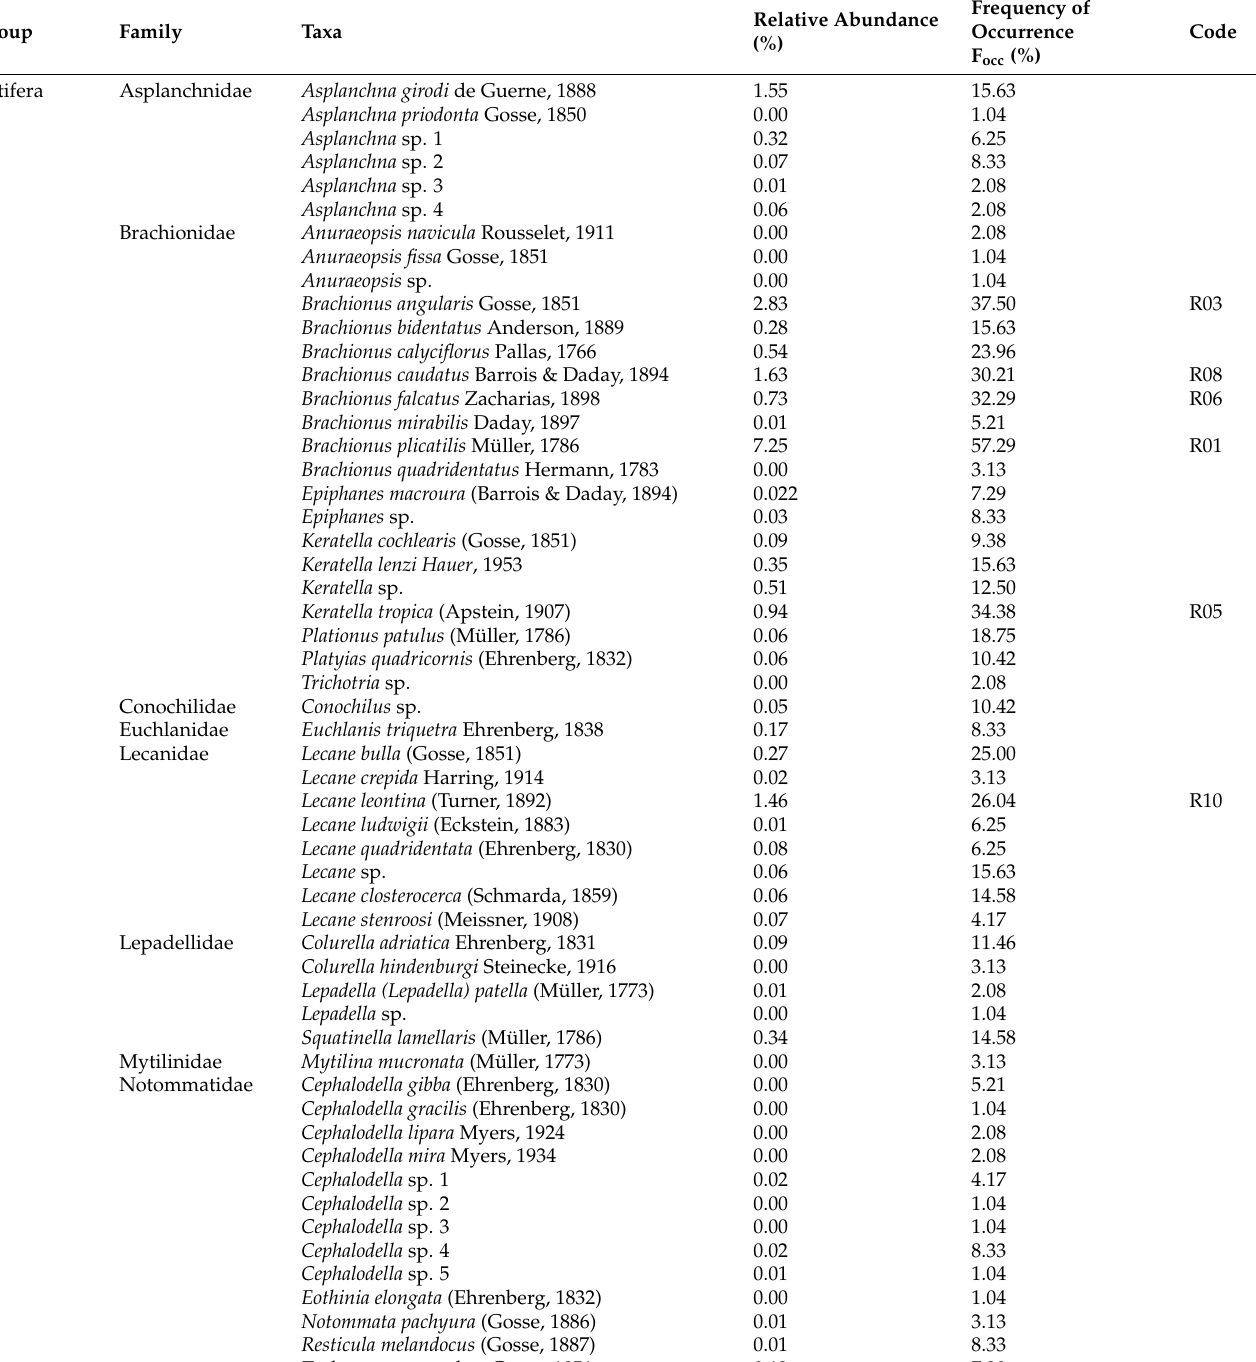
Table 1. List of zooplankton taxa, their relative abundance (in %) and frequency of occurrence (in %). The inventoried taxa were sampled in Nokou é Lagoon during 6 bimonthly surveys carried out between November 2019 and September 2020. The last column indicates the codes of the most frequent (F occ > 0.25) and abundant (relative abundance higher than 0.5%) taxa, used to study their relationship with environmental